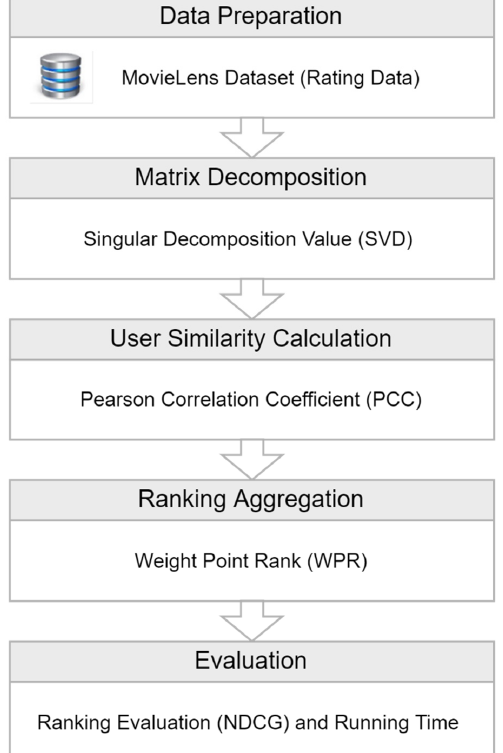
Figure 3. Research Figure 3. Research stages.